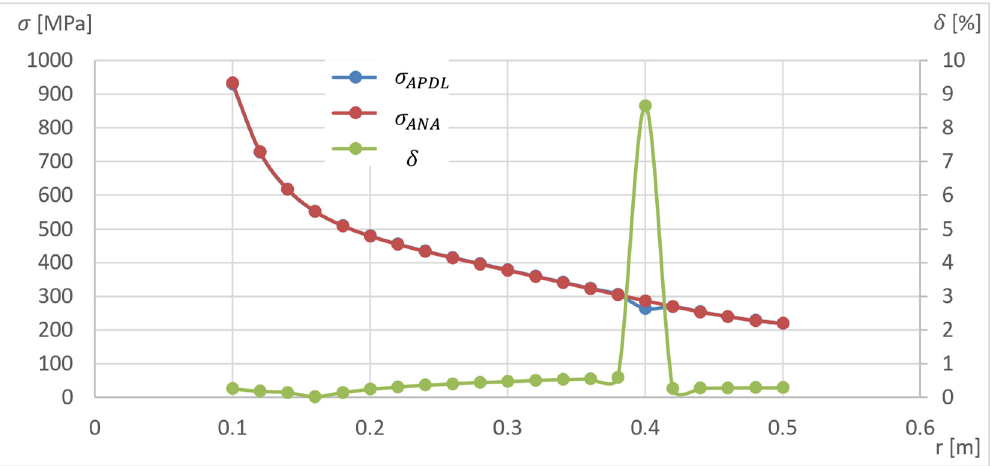
Figure 6. Results of program validation in APDL to determine the stress distribution in the